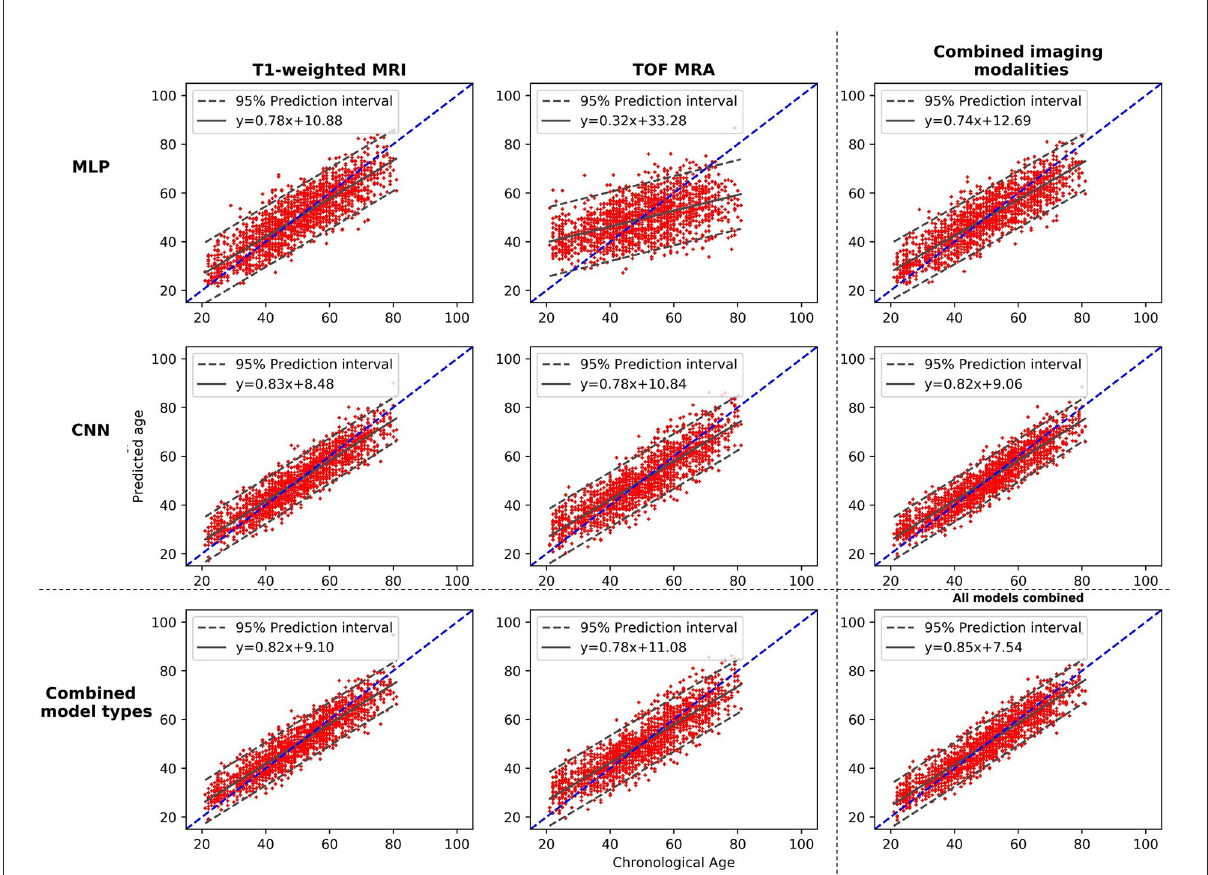
FIGURE3 Plots of the brain age predictions vs. the chronological age for the different models and the different possible model combinations. The dashed line shows the diagonal, and the plain line shows the fitted regression line, with its equation. MLP, Multilayer perceptron; CNN, Convolutional neural network; T1-weighted MRI, T1-weighted magnetic resonance imaging; TOF MRA, Time-of-flight magnetic resonance